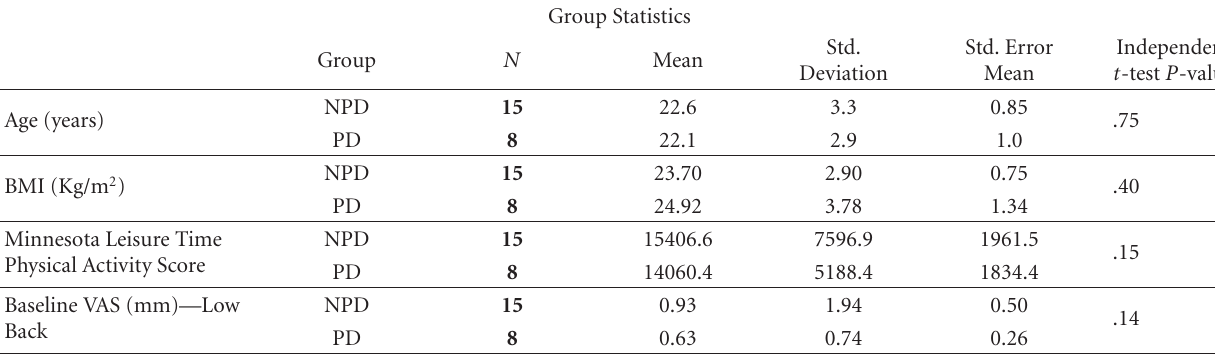
Table 1: Baseline characteristics of participants.